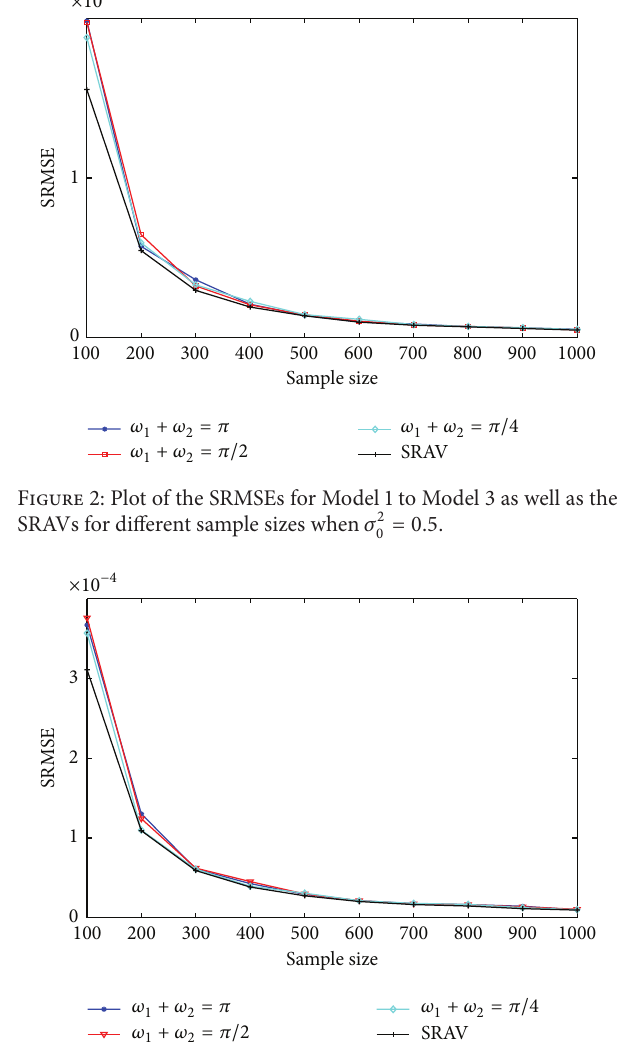
Figure 3: Plot of the SRMSEs for Model 1 to Model 3 as well as the SRAVs for different sample sizes when 𝜎 2 0 = 1.0 .